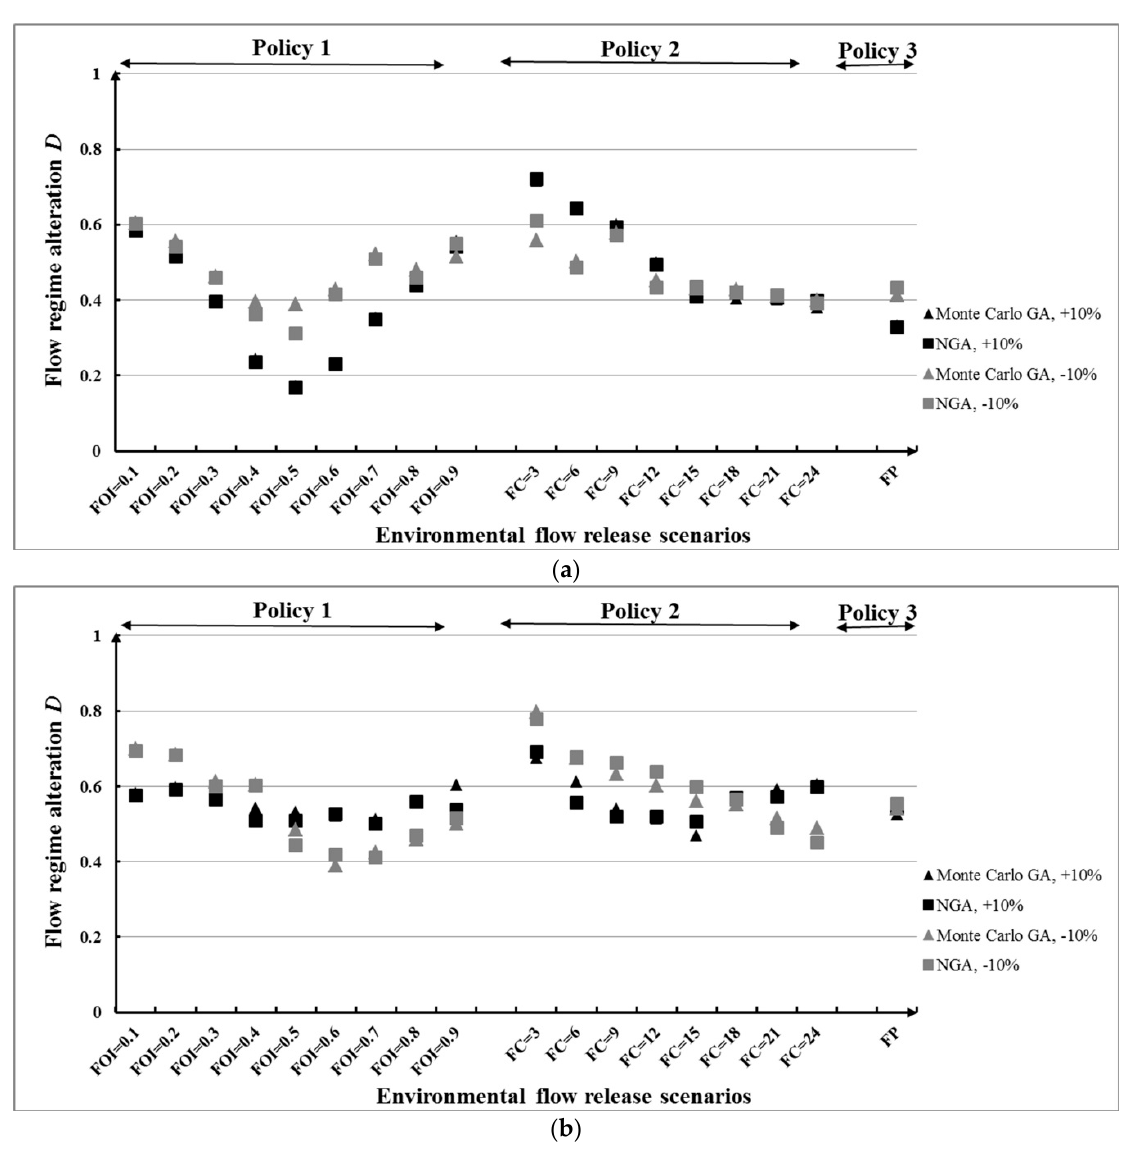
Figure 15. D for different e-flow release policies under different inflow conditions: ( a ) Change of average value and ( b ) change of standard deviation value.